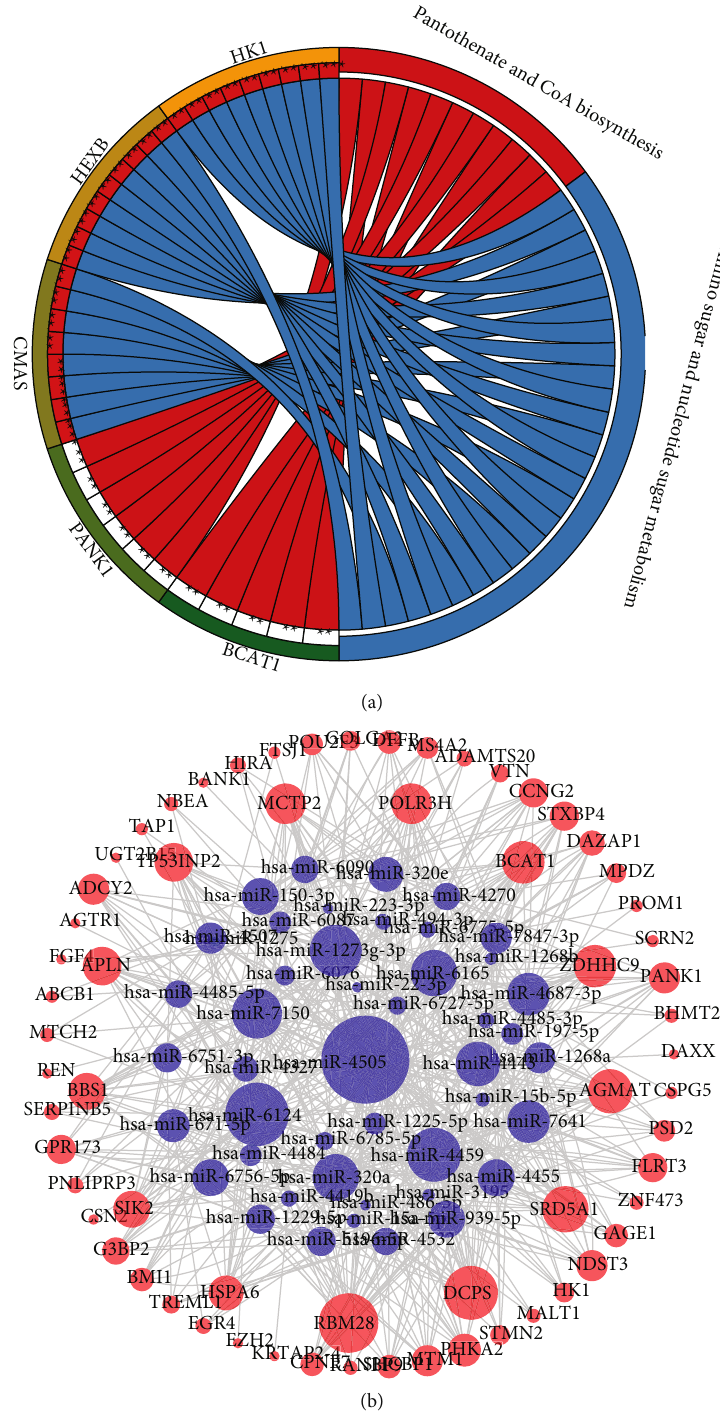
Figure 3: Functional enrichment analysis: (a) KEGG enrichment analysis of di ff erential genes; (b) network plot of miRNA interactions with di ff erential target genes, where blue is miRNA, red is gene, and the size of the dot is degree, where the larger the dot, the closer the connectivity with other nodes at that point, and the more important the dot